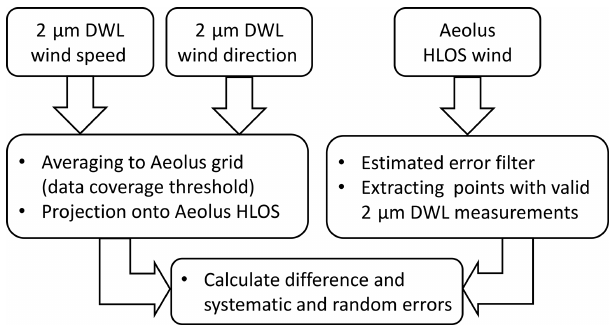
Figure 4. Sketch of the processing steps used to compare 2µm DWL measurements with Aeolus Figure 3. Histogram of the difference of wind speeds derived from 2µm DWL data by means of one scanner revolution and five scan- − v ner revolutions ( v 2µm 2µm 5-scans ) for all flights performed 1-scan during the AVATARE campaign (see also Table 1). The mean and the standard deviation (SD) of the data are indicated by the inset.